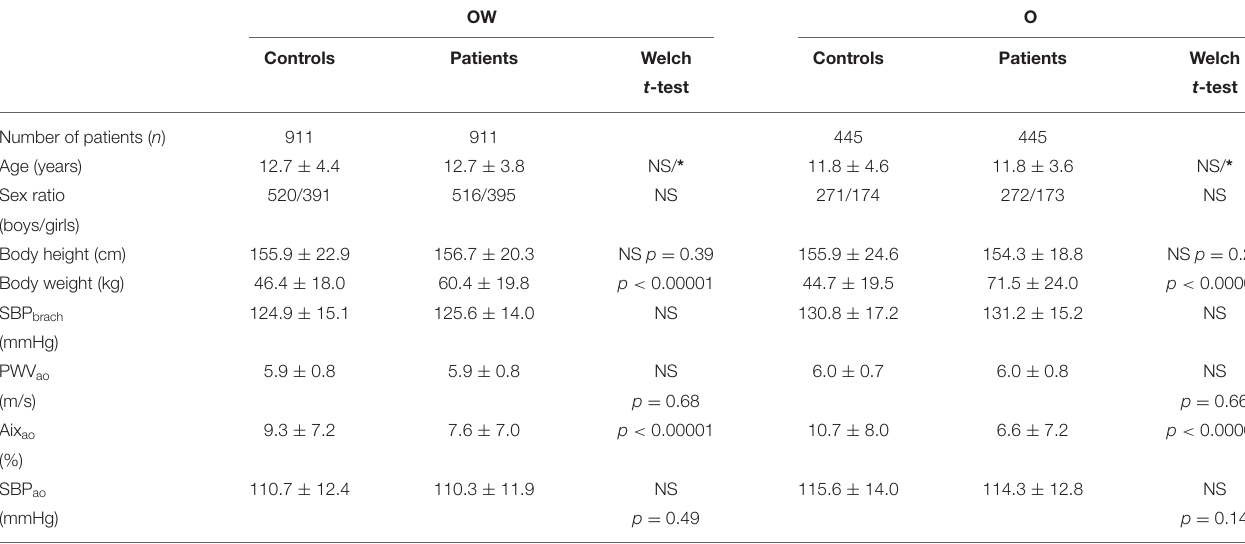
TABLE 4 | Characteristics of OW and O patients vs. controls and AFP values after propensity score